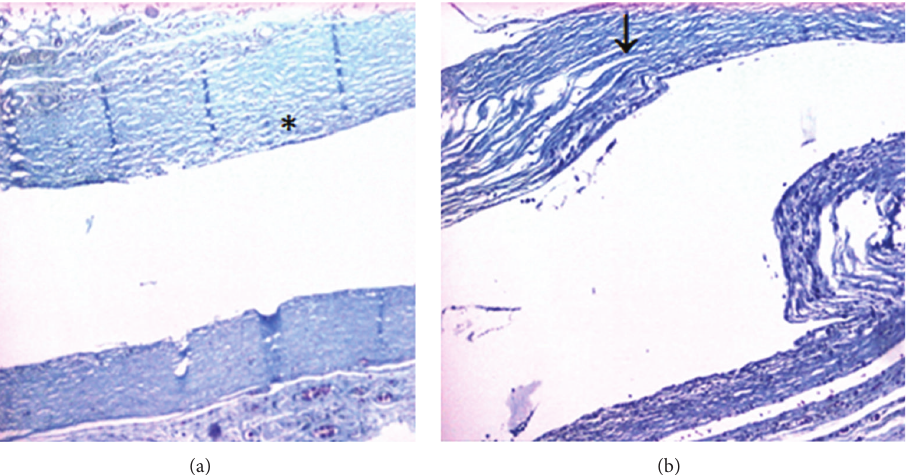
Figure 9: Photographs of sites 60 days after implantation of PLDLA/PCL-T membranes. (a) Site implanted with the 100/0 blend showing dense, well-organized collagen ( ∗ ),(b)siteimplanted with the90/10 blend showing mature, loosely organized collagen and little inflammatory infiltrate ( ↓ ). Staining: Masson’s trichrome. Magnification: